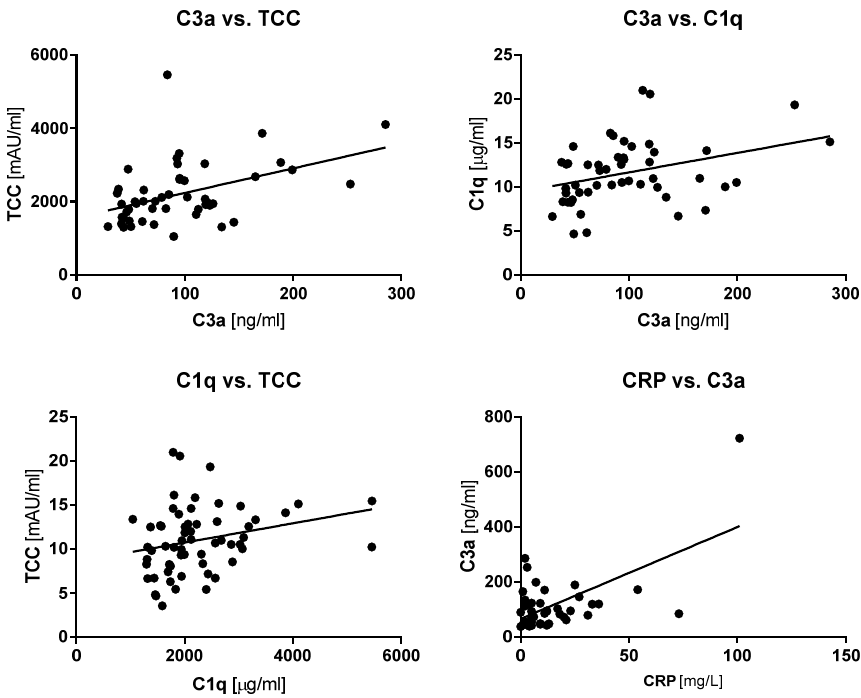
Figure 2. Associations between C3a, TCC, C1q, and CRP. x- and y-plots showing significant correlations between C3a and TCC as well as between C3a and C1q, and TCC and C1q, but no significant correlation between CRP and C3a.